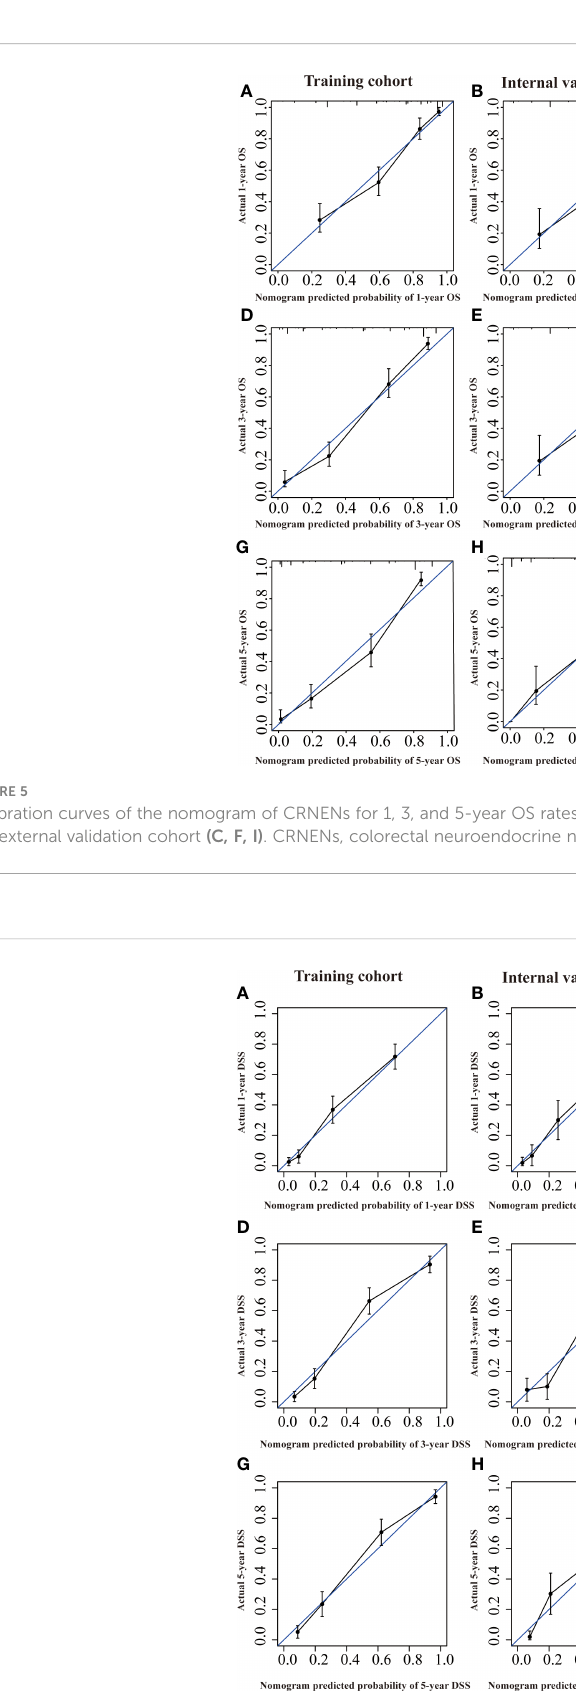
FIGURE 6 Calibration curves of the nomogram of CRNENs for 1, 3, and 5-year DSS rates in the training cohort (A, D, G) , the internal validation cohort (B, E, H) , and the external validation cohort (C, F, I) . CRNENs, colorectal neuroendocrine neoplasms; DSS, disease-speci fi c